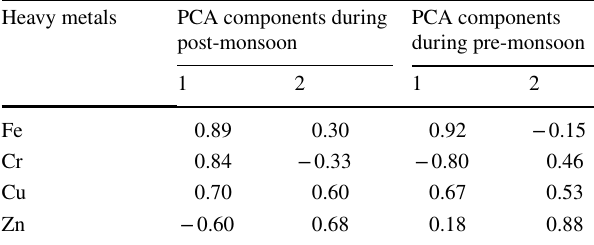
Table 4 PCA components values of heavy metals Heavy metals PCA components during